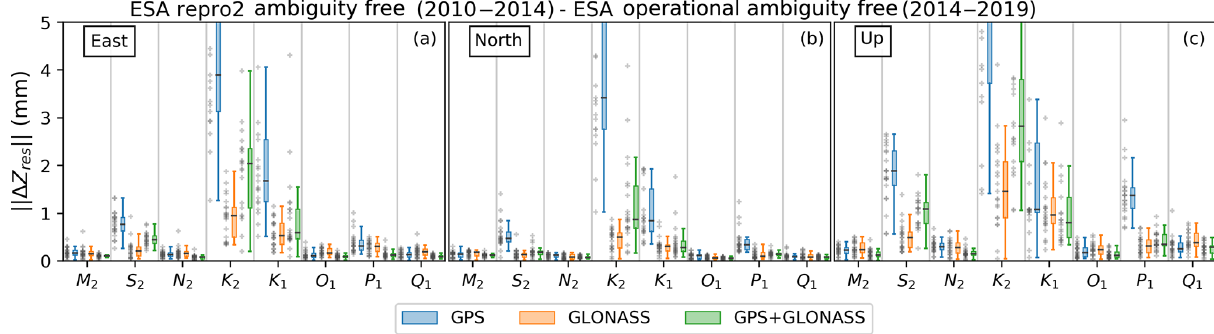
Figure 11. OTL vector differences between ESA repro2 (2010.0–2014.0) and ESA operational (2014.0–2019.0) OTL estimates: GPS (blue), GLONASS (orange) and GPS+GLONASS (green) constellation modes present. Grey crosses are as per Fig. 3.